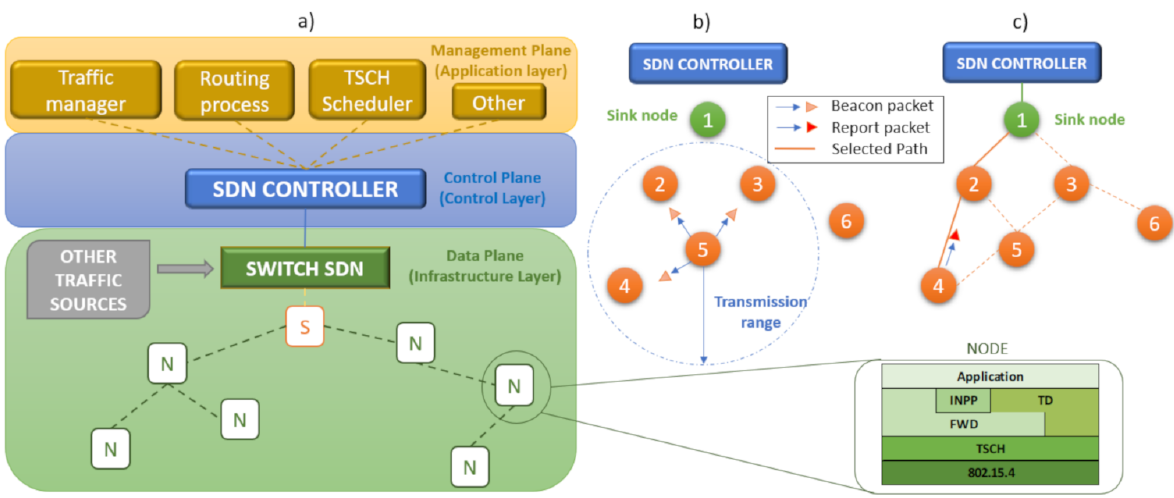
Figure 1. ( a ) Software Defined Network (SDN) architecture, ( b ) beacon packet, ( c ) report